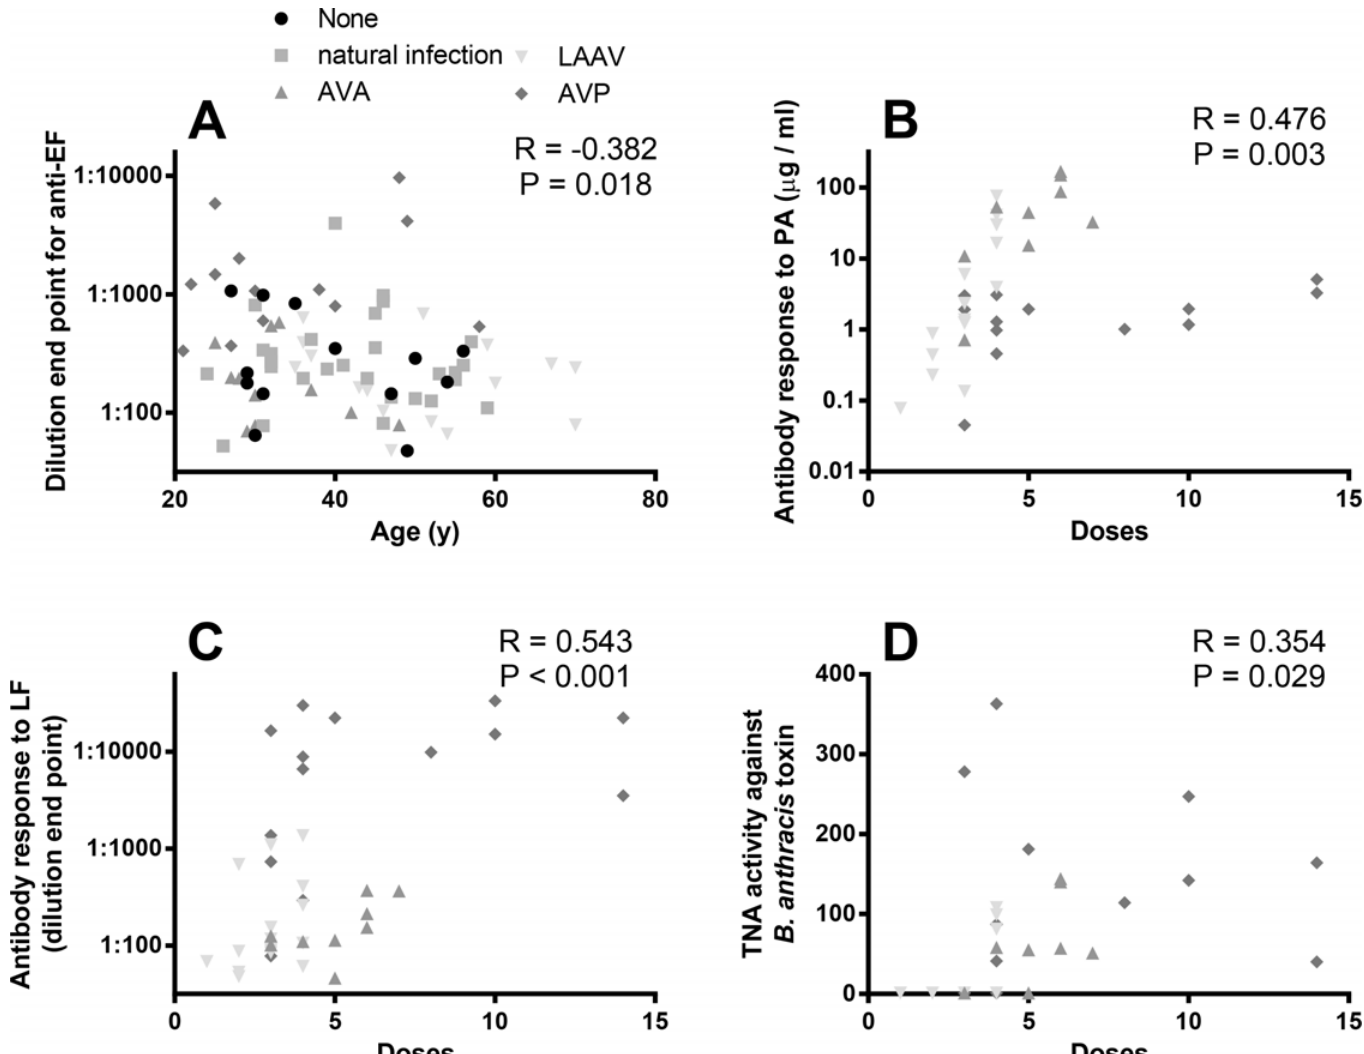
Fig 2. Correlations between immune response to B . anthracis antigens and individual ’ s age and the number of vaccine doses. Panel A shows the correlation between age and antibody response to EF, in participants of a study which included individuals who had suffered from cutaneous anthrax previously, been vaccinated with either AVA, LAAV or AVP, or have no history of exposure to anthrax antigens. Antibody responses were measured by ELISA estimating antigen specific antibody in μ g / ml. Panels B-D show the correlation between the numbers of doses of vaccine received and antibody response. Antibody responses were measured by ELISA estimating antigen specific antibody against PA (panel B), LF (panel C) and toxin neutralisation activity (Panel D). Partial correlation analyses indicated a significant negative correlation between the parameters (marked on the